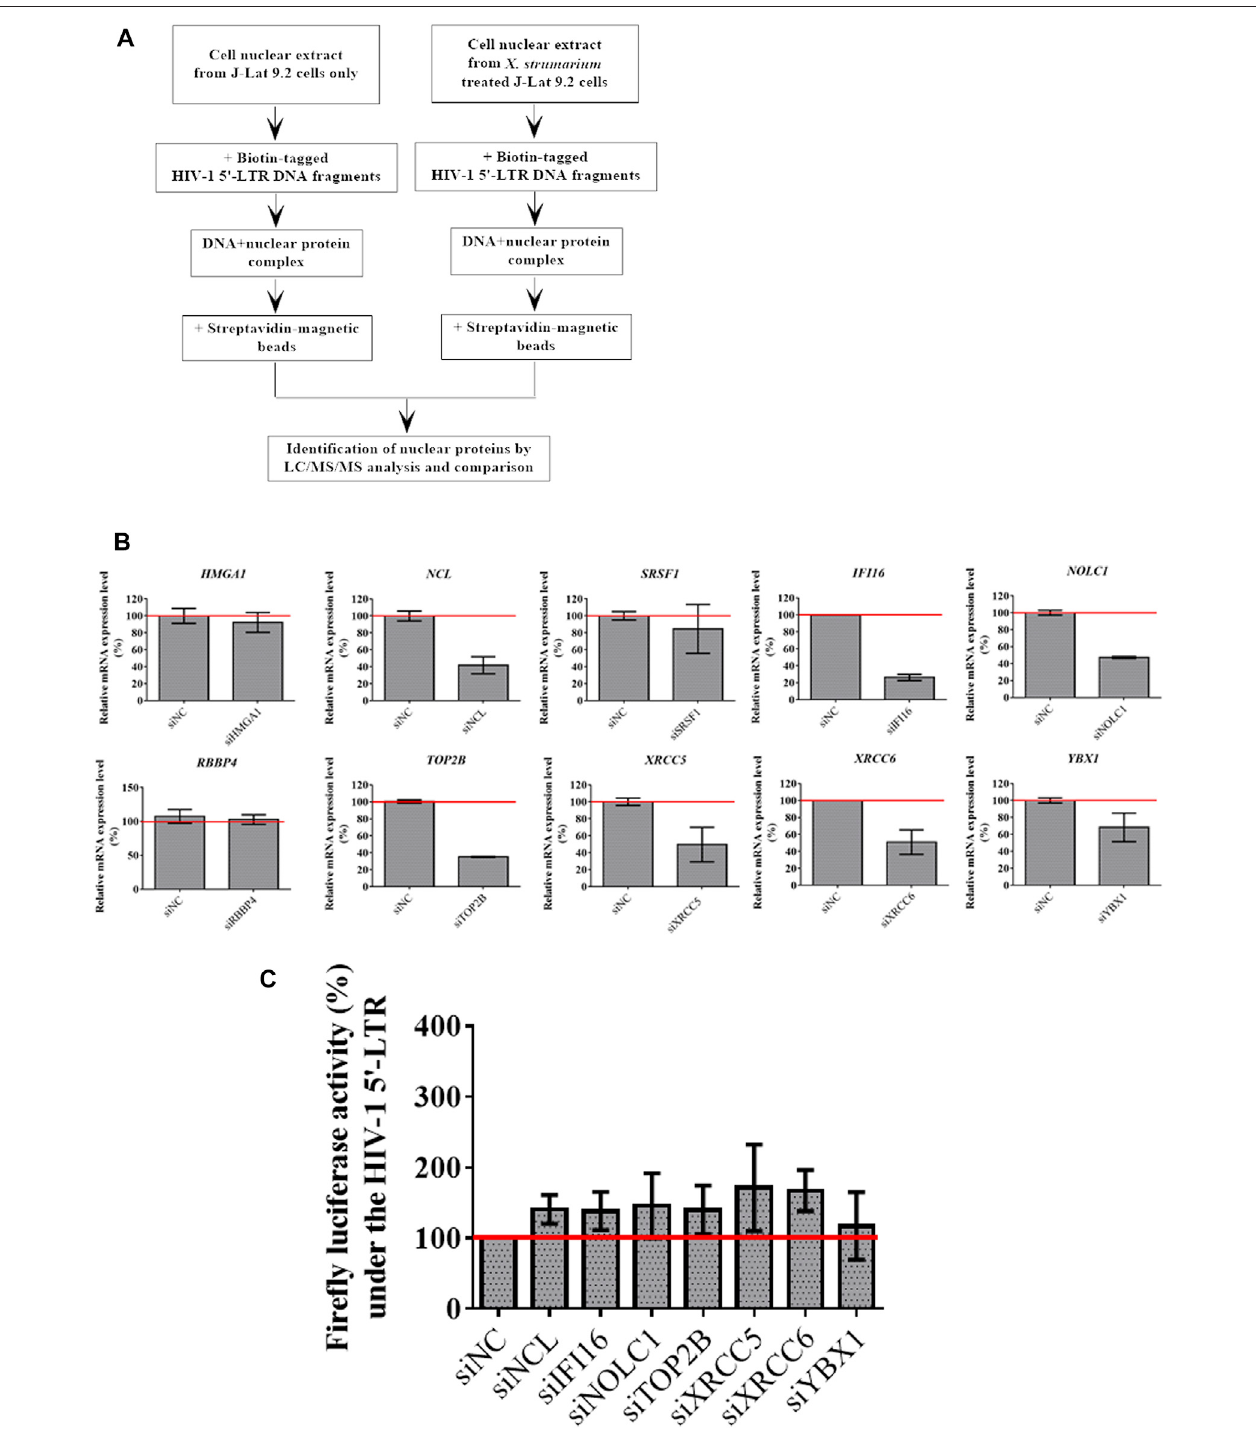
FIGURE4| Identi fi cationof X.strumarium -associatednuclearregulatoryproteinsthatwereinteractedwiththeHIV-15 ′ -LTRregionoftheHIV-1genome. (A) fl owchart forDNAaf fi nitycaptureof X.strumarium -associatednuclearregulatoryproteinsinteractingwithHIV-15 ′ -LTRregion(nt229 – 455). (B) RelativemRNAexpressionlevel(%)of 10nuclearregulatorygenes- HMGA1 , NCL , SRSF1 , IFI16 , NOLC1 , RBBP4 , TOP2B , XRCC5 , XRCC6 ,and YBX1 inTZM-blcellswithpcDNAHIV-1viraltat- fl aggeneplasmid after transfection with siRNAs for these 10 interest genes, respectively for 24 h. The siRNAs of interest genes included siHMGA1, siNCL, siRBBP4, siYBX1, siUSF2, siIFI16,siNOLC1,siXRCC5,siXRCC6,siTOP2B,andsiSRSF1.ThescramblesiRNAsweretransfectedintotheTZM-blcellsandservedasthenegativecontrols(siNC).After 24 h transfection, the mRNA expression levels of these 10 interest genes were quanti fi ed by RT-qPCR method according to the manufacturer ’ s recommendations.